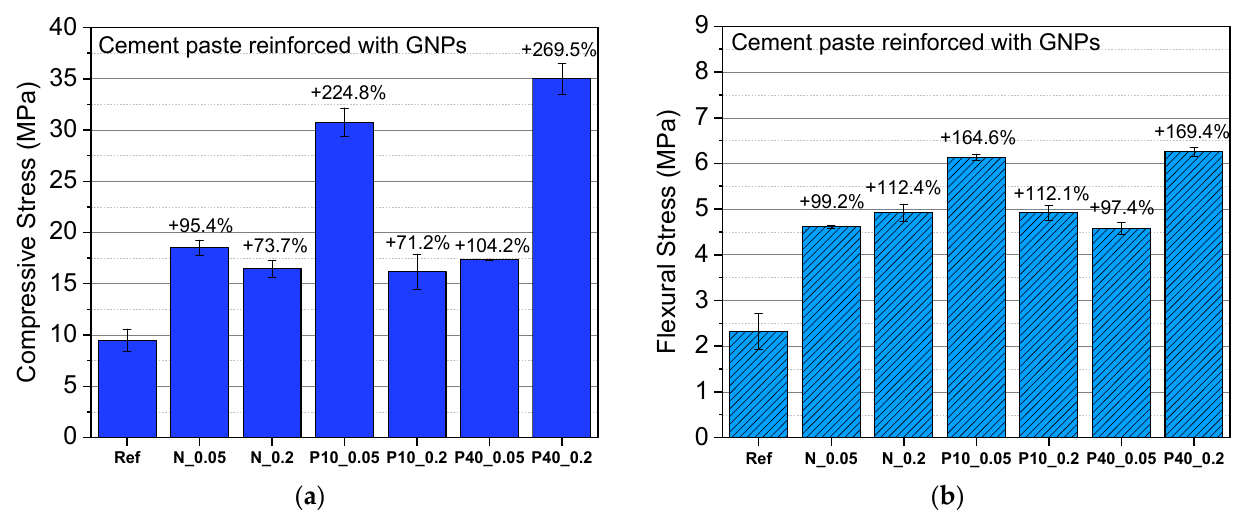
Figure 8. Average ( a ) compressive strength and ( b ) flexural strength of cement composites with GNPs at 28 d.